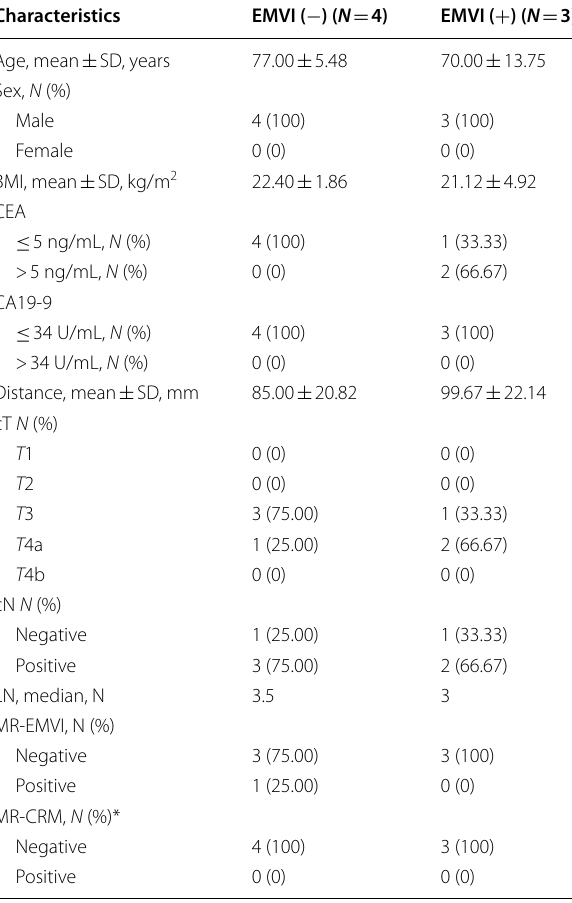
Table 2 Associations between EMVI and clinical risk predictors in validation cohort